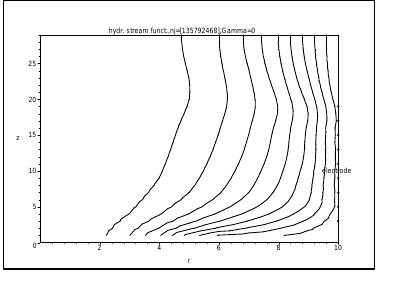
Figure 3. The stream functions for nj = [135792468] , ψ ∈ (0 . 00 , 0 . 16) , Γ = 0 .